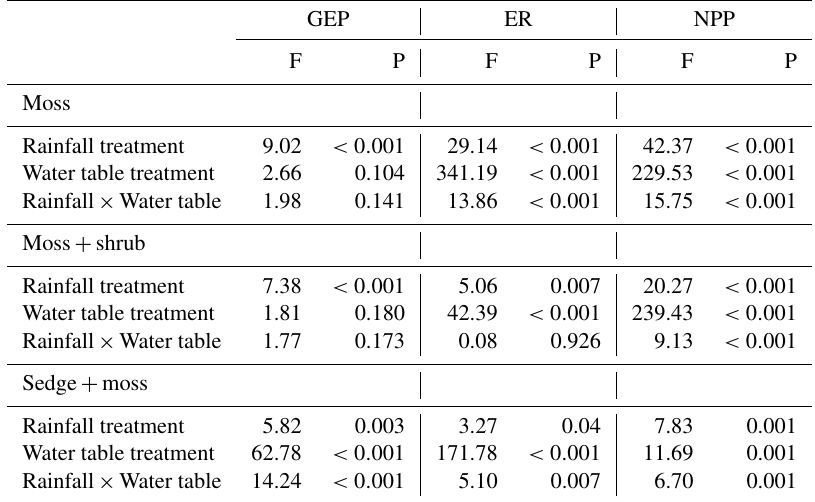
Table 2. Results of the mixed effects models on CO 2 exchange parameters from the monolith experiment. Numerator degrees of freedom for rainfall frequency, water table treatment fixed effects, and their interaction were 2, 1, and 2, respectively, in all models. The denominator degrees of freedom for all models was